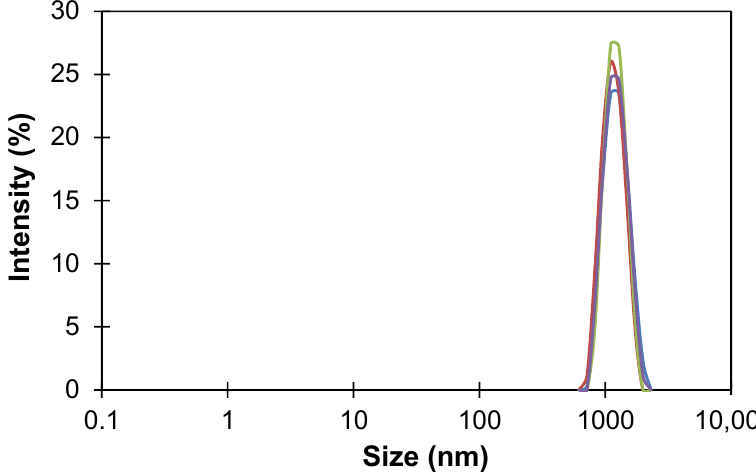
Figure 1. Size distribution of HCPS MN200 in chloroform.